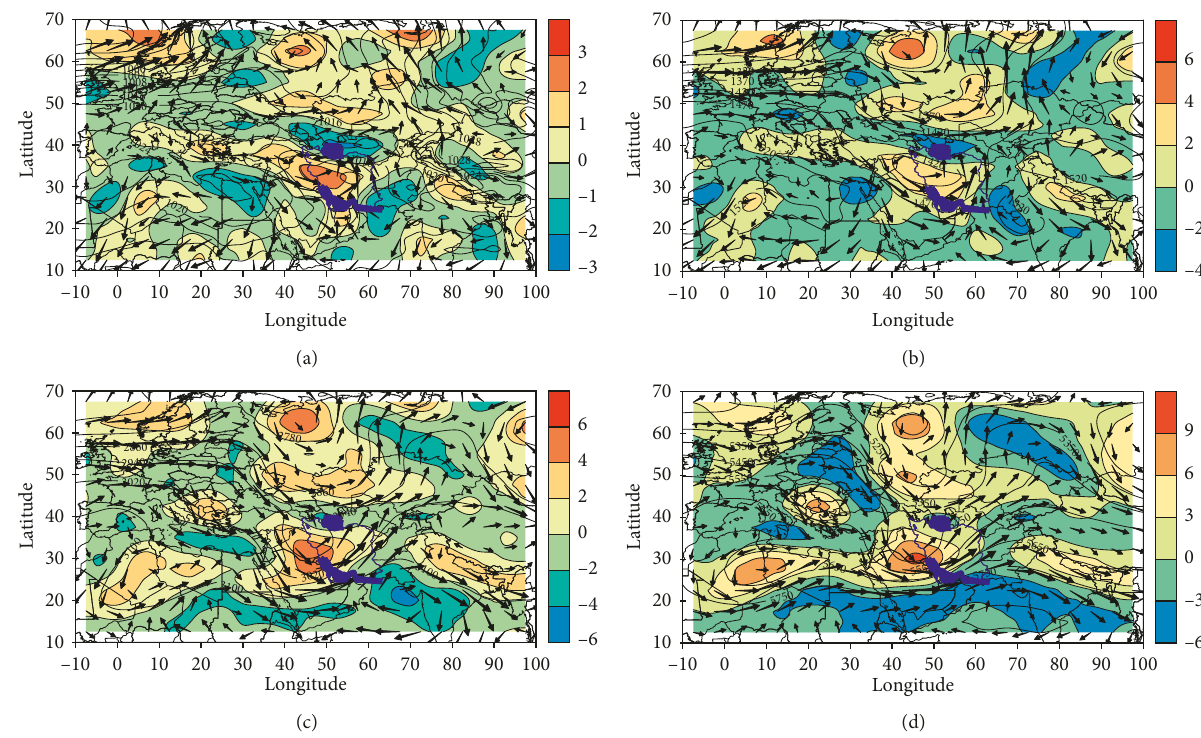
Figure 4: (a) 1000hPa height (contours), vorticity (5 × 10 − 5 ), and wind flow (m/s). (c) 700 hPa height, vorticity (5 × 10 − 5 (5 × 10 − 5 S − 1 wind flow